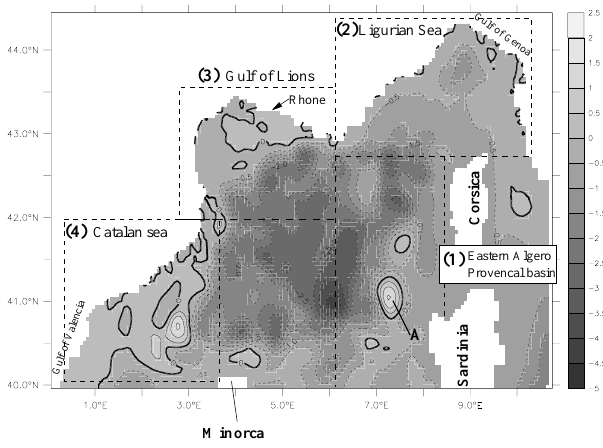
Fig. 2. Barotropic stream function of the RM model on 3 March, year I. Isoline units are in Sverdrups (Sv), at 0.5-Sv intervals. Four sub-regions, (1), (2), (3), (4) are delimited by dashed lines. (A) denotes an anticyclonic eddy.